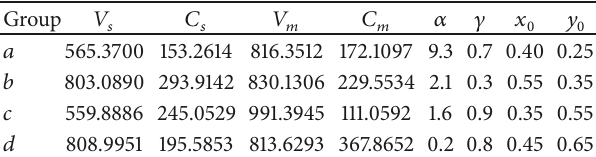
Table 2: The values of simulation